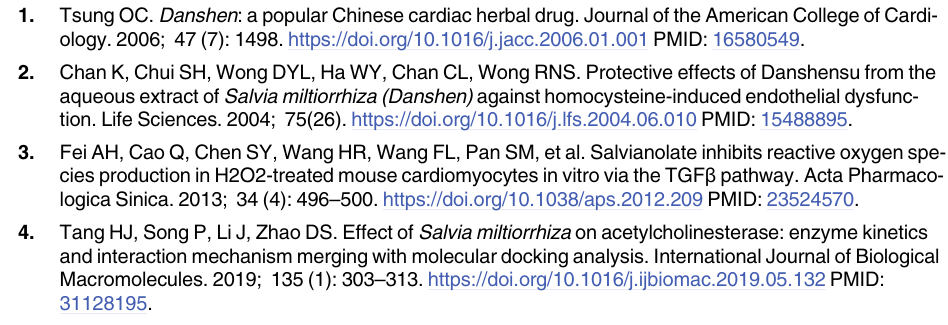
S1 Table. GenBank accessions of the four intergenic spacers of the 40 cultivated S . miltior- rhiza